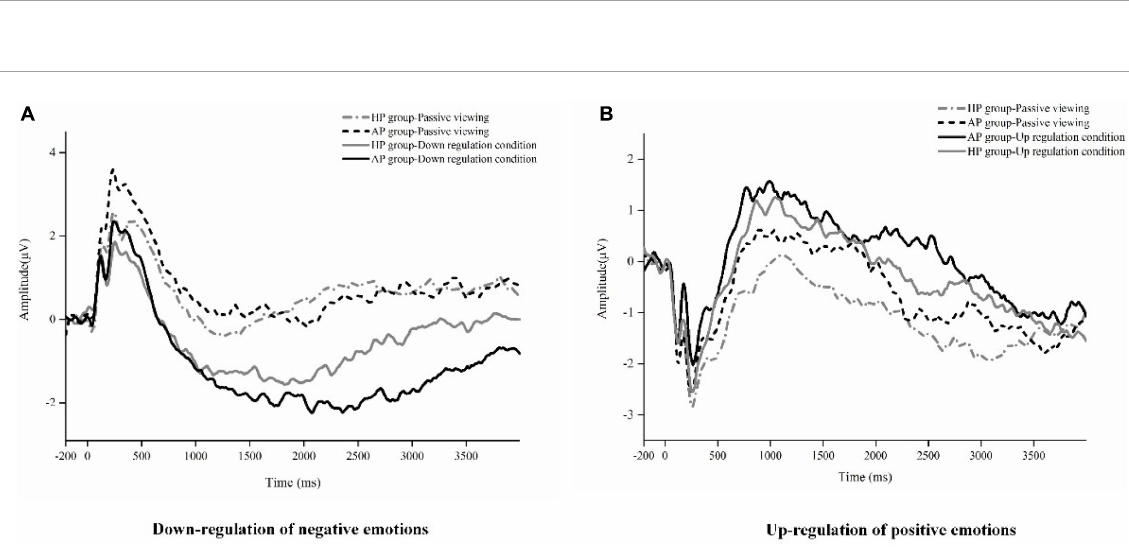
FIGURE5 Mean waveforms by condition in the AP and HP groups. (A) Average stimulus-locked ERPs for two experimental conditions (down-regulation, passive viewing) in the AP and HP groups. (B) Average stimulus-locked ERPs for two experimental conditions (up-regulation, passive viewing) in the AP and HP